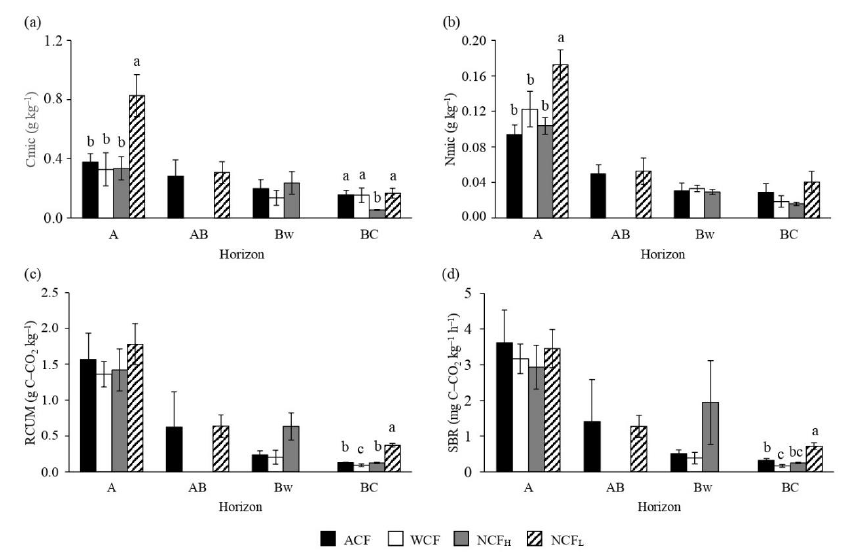
Figure 5. Concentrations of microbial biomass carbon (Cmic; a ), microbial biomass nitrogen (Nmic; b ), cumulative amount of CO 2 -C evolved during 21-days incubation experiment (RCUM; c ) and soil basal respiration (SBR; d ) of soils under an abandoned chestnut forest (ACF), a chestnut forest for wood production with a tree density of 151 plants ha –1 (WCF), a chestnut forest for nut production with a tree density of 120 plants ha –1 (NCF H ) and a chestnut forest for nut production with a tree density of 98 plants ha –1 (NCF L ). Error bars are the standard errors. Within each horizon, different letters indicate significant differences by Tukey’s t -test p ≤ 0.05.